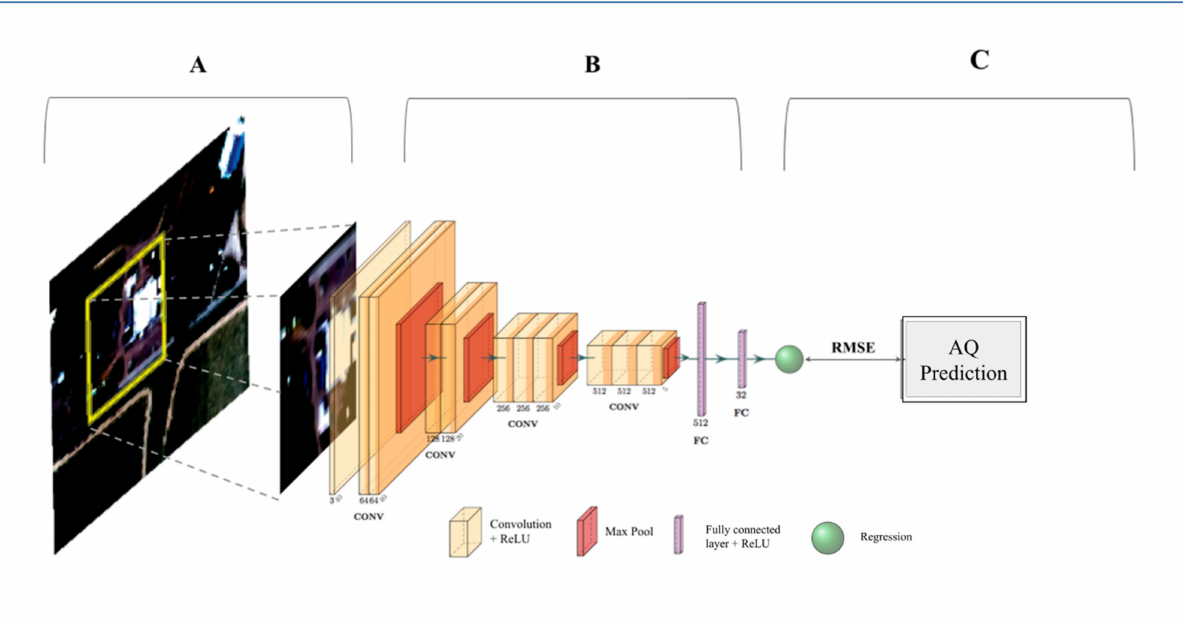
Figure 1. Methodology Flowchart. ( A ) Single satellite imagery patches are input to the CNN 40 × 40 pixels (100 m × 100 m) for PM 2.5 and 80 × 80 pixels (200 m × 200 m) for NO 2 , each patch corresponds to one target value from a continuous LUR surface. ( B ) The satellite images are applied to a CNN, which consists of stacked layers of convolution and nonlinear activation functions (rectified linear unit (ReLU); yellow blocks), followed by max pooling layers (red blocks) to spatially down- sample the features at the end of each convolutional block. Lastly, the convolutional features are flattened and fed into fully connected layers (showed in purple) and ( C ) regressed to the LUR training data to predict continuous PM 2.5 /NO 2 estimates. RMSE was used to measure the error and evaluate the model. (Further details: Section S1 of Supplementary Material). (This figure was developed using the PlotNeuralNet package